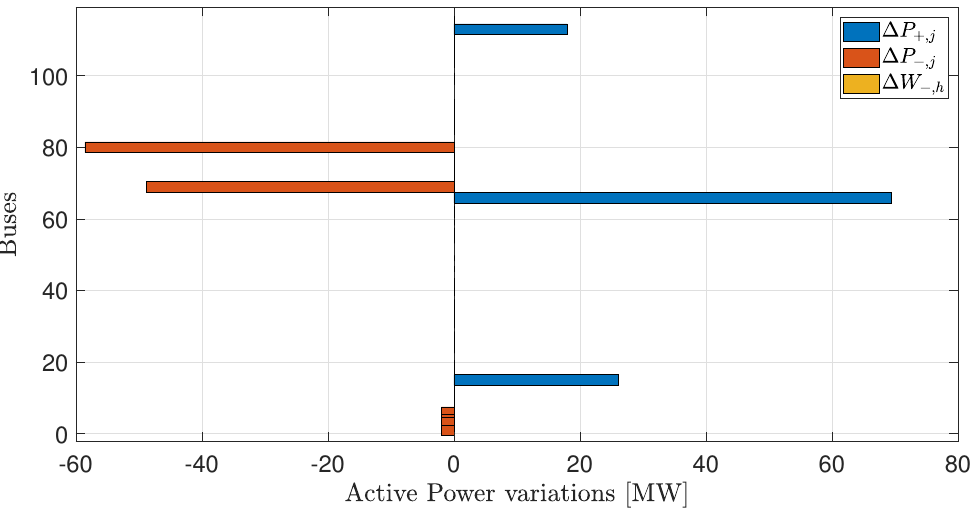
Figure 5. Set-point variations of DGUs and RESU after the active power control − Scenario